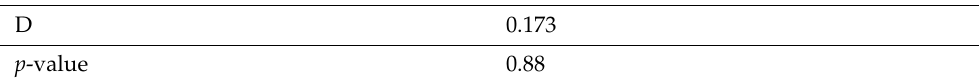
Table 3. Results of the Kolmogorov–Smirnov test (KS test) for differences between male and female distribution of septal deviation in absolute values (i.e., overall magnitude of deviation). D = vertical distance between the two cumulative distributions. Asterisks indicate significance: * p -value ≤ 0.05; ** p -value ≤ 0.01; *** p -value ≤ 0.001. Sample size: 46 specimens.